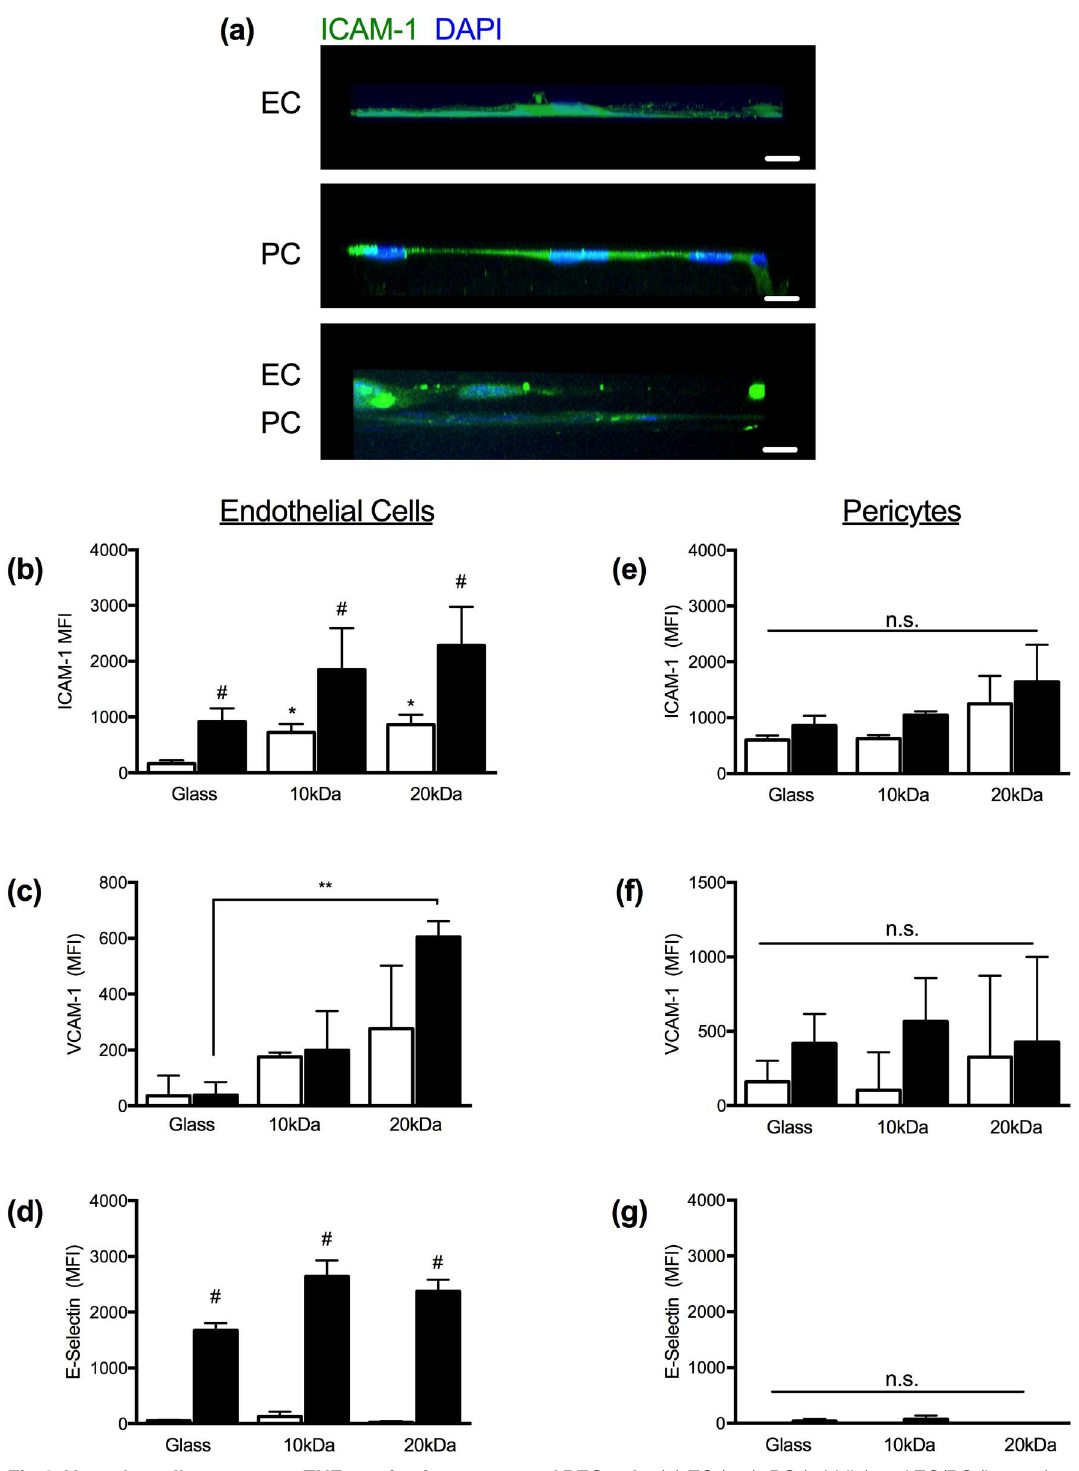
Fig 4. Vascular cell response to TNF α -activation on porated PEG gels. (a) EC (top), PC (middle)and EC/PC (bottom) cell layers in profile stainedfor ICAM-1 (green) and DAPI (blue) on 20kDagels. Scale bars are ten microns. (b-d) Flow cytometry results of ECs stained for ICAM-1 (b), VCAM-1 (c), and E-selectin (d) under control and TNF α -activated conditions on RGD-coated glass (E > 2GPa), 10kDa (E: 83.8kPa), or 20kDa (E: 54.7kPa) hydrogels. (e-g) Flow cytometry of PCs stainedfor ICAM-1 (b), VCAM-1 (c), and E-selectin (d) under control and TNF α -activated conditions on RGD-coated glass (E > 2GPa), 10kDa (E: 83.8kPa), or 20kDa(E: 54.7kPa)hydrogels.